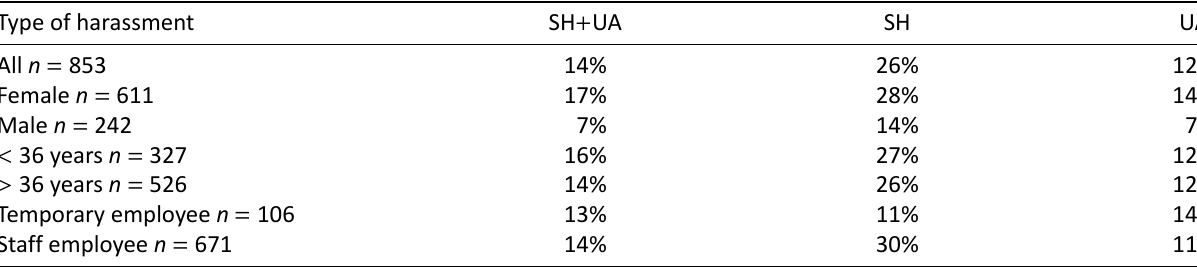
Table 6. Frequency of use of avoiding coping strategy.